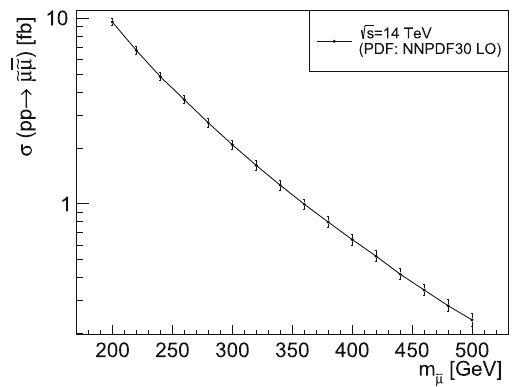
Fig. 4 Cross section of the smuon production at leading order as a function of the smuon mass m ˜ μ . The uncertainties are related to